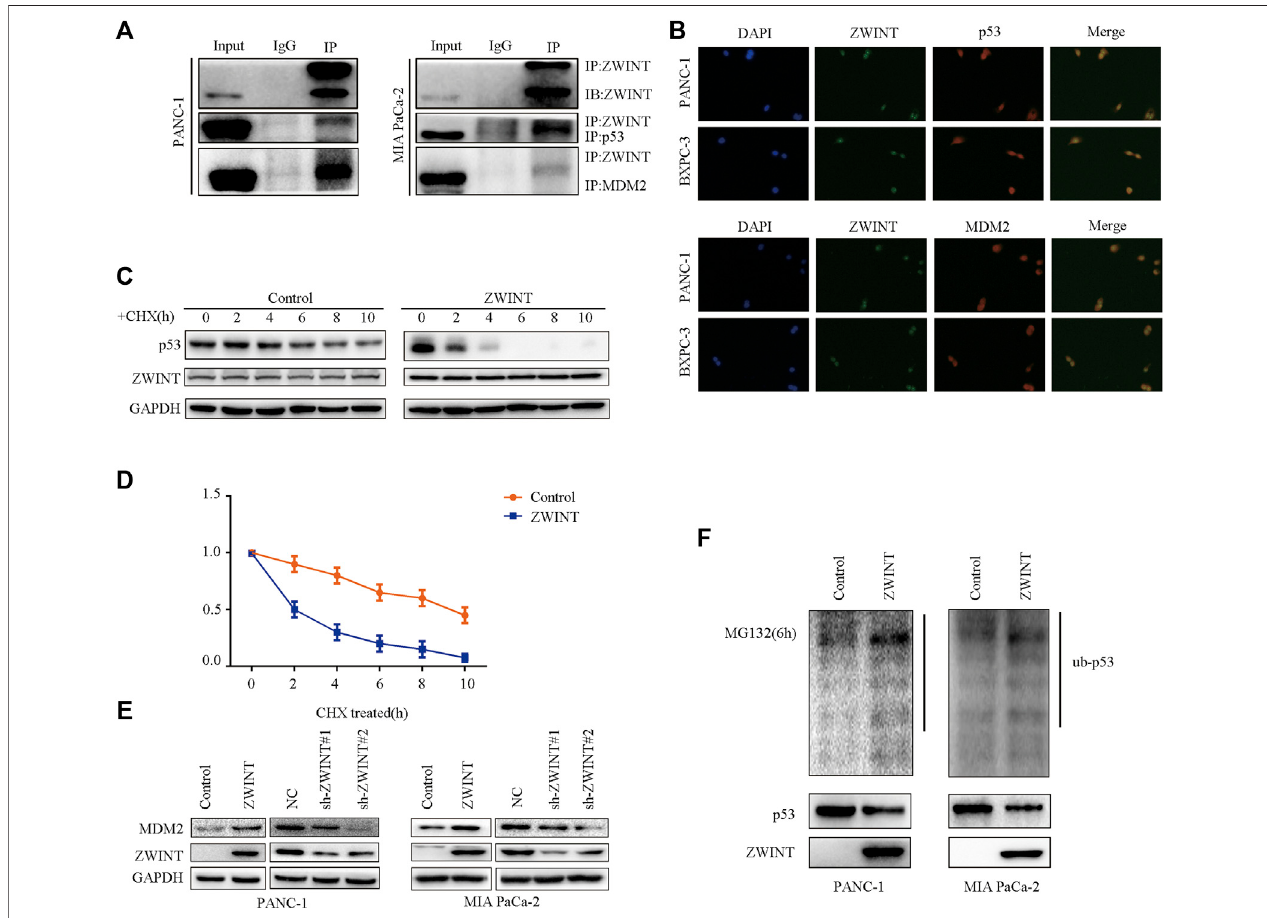
FIGURE 5 | ZWINT decreases p53 expression by promoting its ubiquitination via enhancing MDM2 function. (A) Immunoprecipitation analysis the interaction of ZWINT with p53 and MDM2. (B) Immuno fl uorescence analysis theinteraction ofZWINT withp53 and MDM2. (C) Westernblot analysis MDM2 expression in the ZWINT upregulated and knockdown group. (D – E) The protein stability analysis the p53 stability in the ZWINT upregulated group. (F) The ubiquitination assay analysis the p53 ubiquitination level in the ZWINT upregulated group.